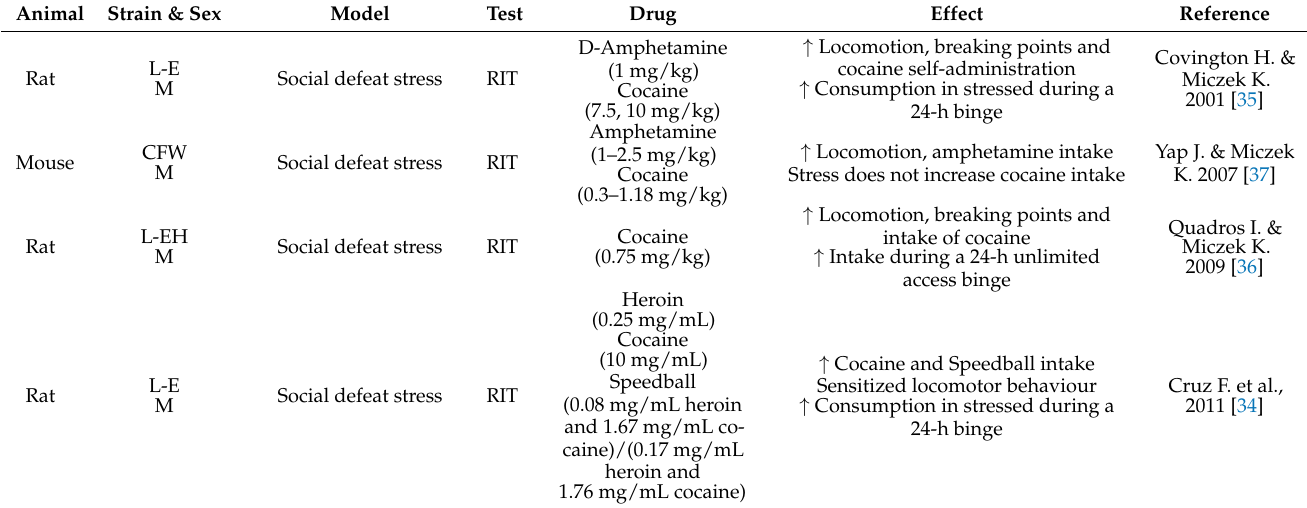
Table 2. Social defeat and psychostimulants